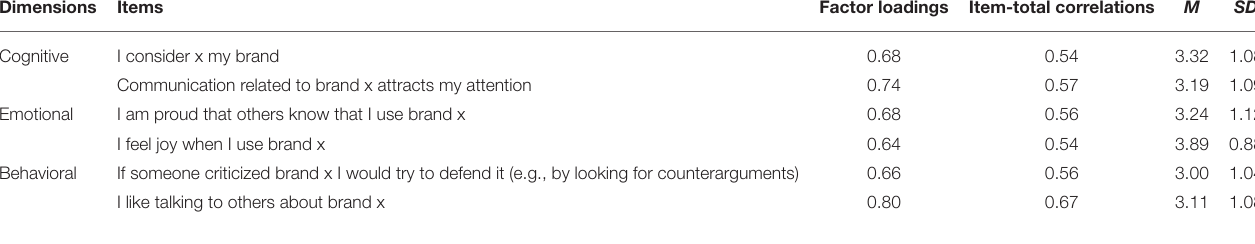
TABLE 2 | The CBE items with factor loadings, item-total correlations, means and standard deviations (Study 1). Dimensions Items